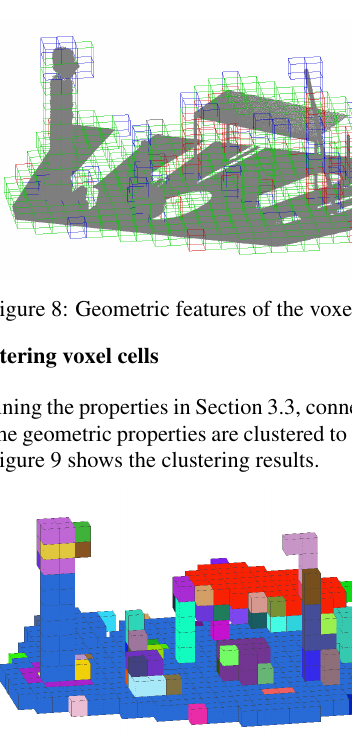
Figure 7: Voxelization of the point cloud with 15 cm voxels A cell is considered as a planar cell if the smallest eigenvalue is 20 times smaller then the second largest eigenvalue, i.e. when λ 2 > 20 . If a cell does not meet the above two criteria, then it λ 3 will be considered as a spherical cell.